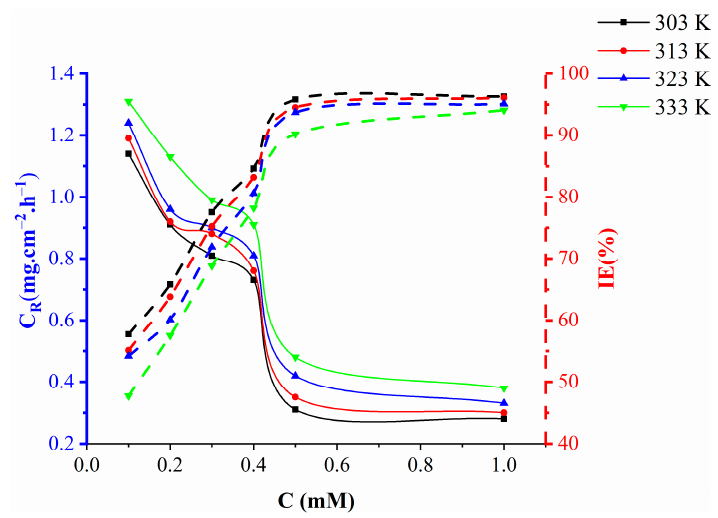
Figure 4. Effect of various concentrations of nicotinehydrazide derivative on the corrosion rate and inhibition efficiency of mild steel immersed in 1 M HCl at different temperatures for 5